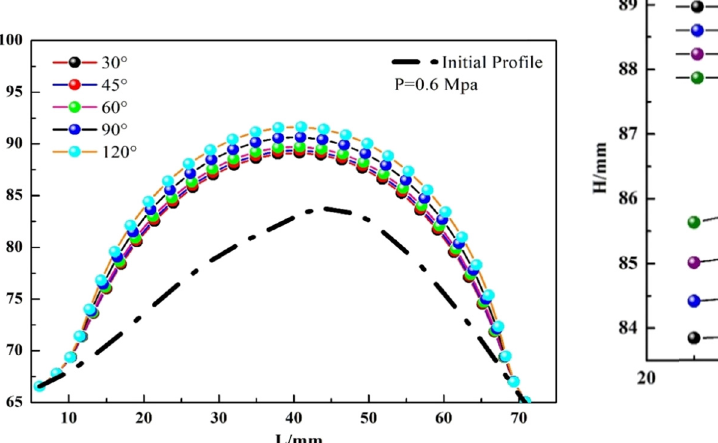
Figure 13: Relationship between maximum deformation height and laying angle under di ff erent